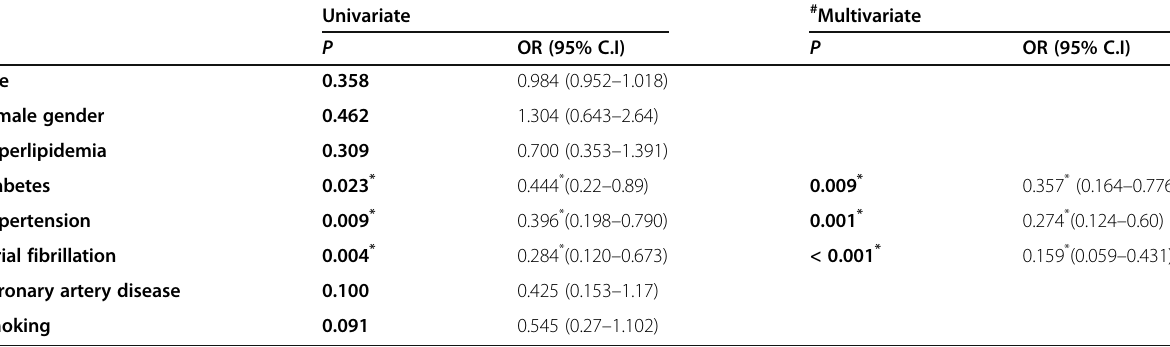
Table 5 Univariate and multivariate analysis between study variable (demographic and risk factors) and good functional outcome